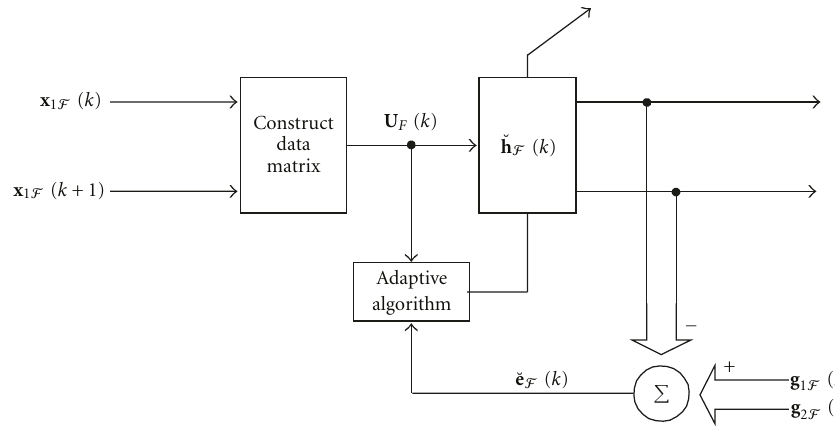
Figure 2: Block diagram of the adaptive